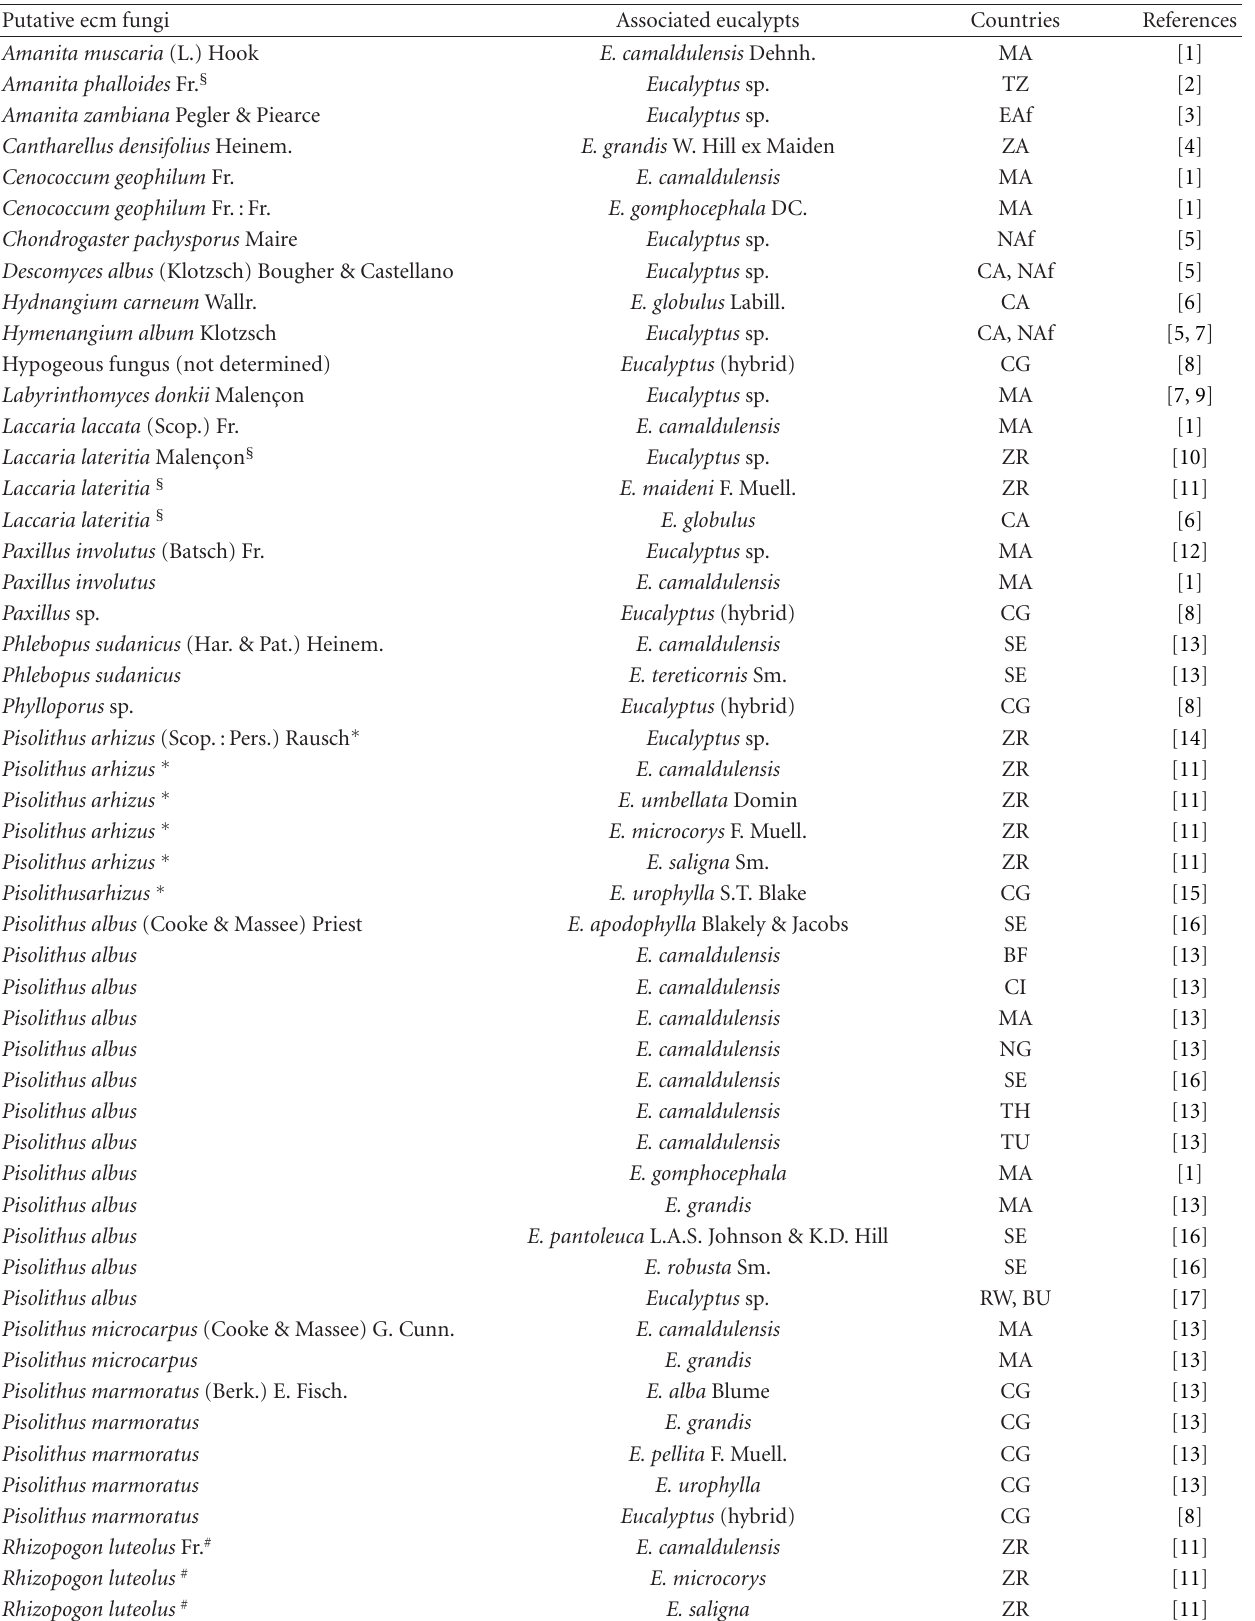
Table 1: List of ectomycorrhizal fungi found associated with eucalypts in Africa with an indication of the country where the observation was made and the